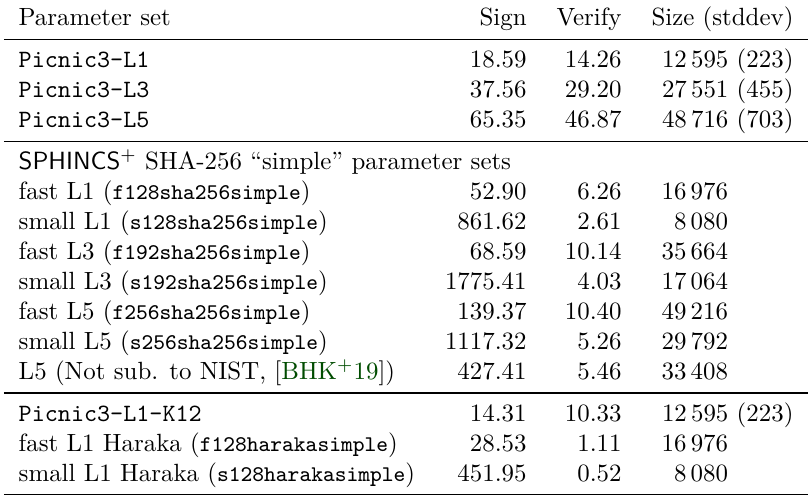
Table 8: Benchmarks of Picnic3 compared to SPHINCS + . Sign and verify times are reported in millions of CPU cycles. Size in bytes. The SPHINCS + instances from the NIST submission are from SUPERCOP (amd64; Skylake (506e3); 2015 Intel Xeon E3-1220 v5; 4 x 3000MHz; samba, supercop-20191017). The SPHINCS + instance from CCS [BHK + 19] are from a 3.5GHz Intel Xeon E3-1275 V3 (Haswell). The Picnic3 instances were run on a 3.6GHz Intel Xeon W-2133